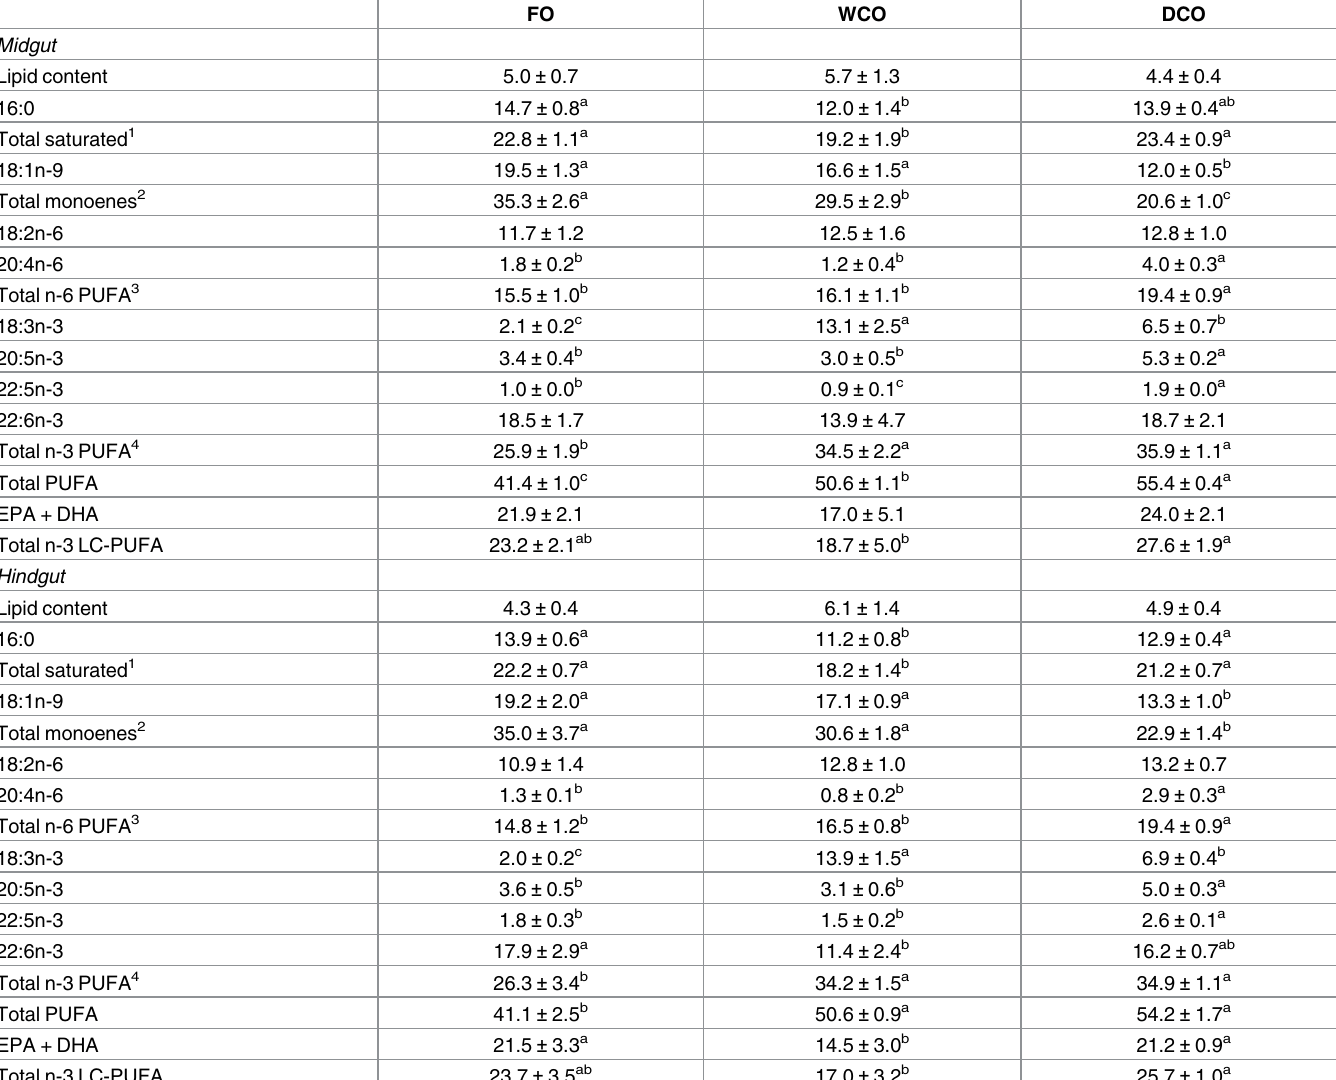
Table 5. Lipid contents (percentage of wet weight) and fatty acid compositions (percentage of total fatty acids) of total lipid of midgut and hindgut (n = 3) after feeding the experimental diets for 12 weeks.